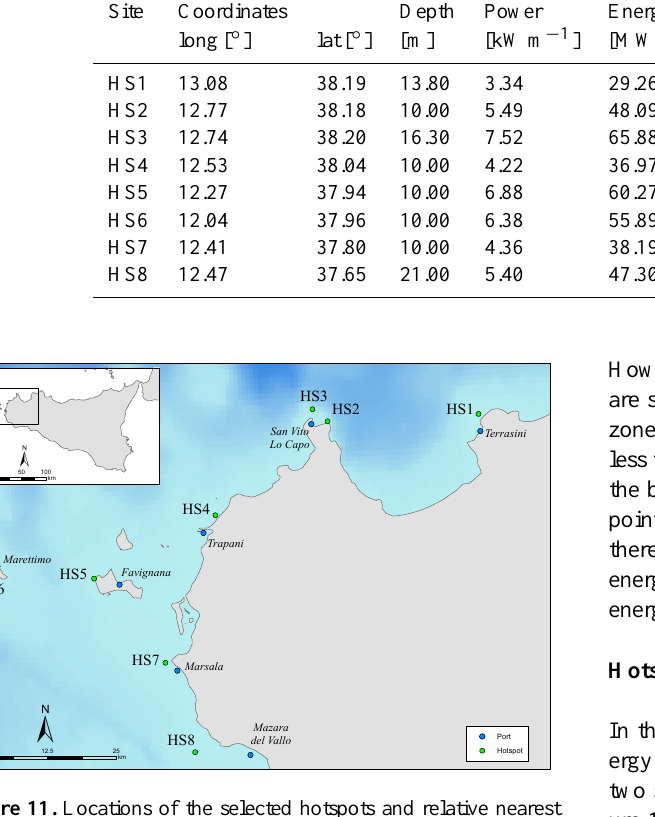
Figure 11. Locations of the selected hotspots and relative nearest ports where WECs could be